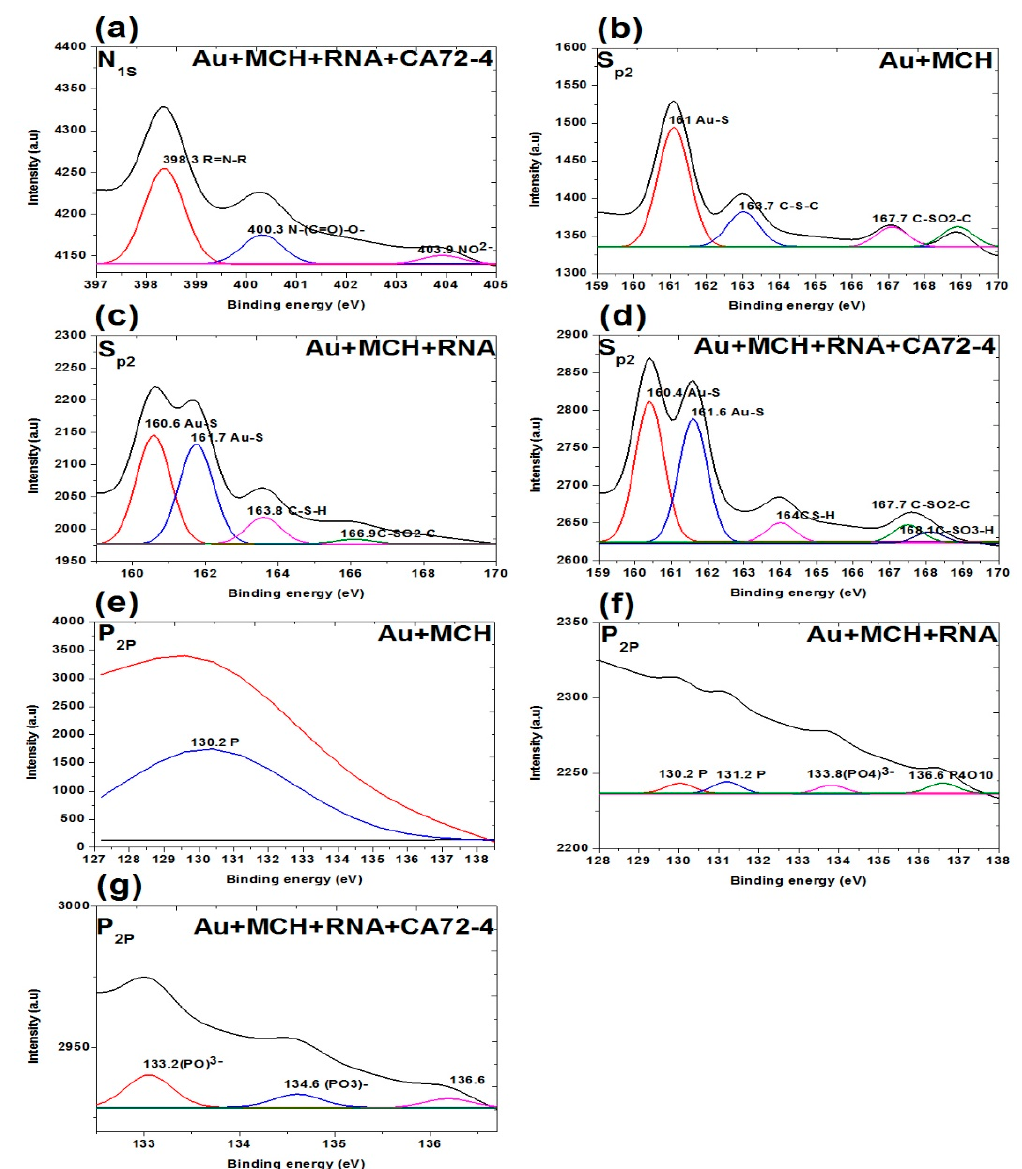
Figure 8. XPS analysis of adsorption of different concentrations of cancer antigen CA 72-4 on our electrochemical sensor. ( a ) N 1s analysis of Oligo-RNA-modified and detected CA72-4. ( b ) S p2 studies on MCH-modified gold membrane. ( c ) S p2 region of the Oligo-RNA membrane. ( d ) S p2 results of Oligo-RNA-modified and detected CA72-4. ( e ) P 2p region of MCH-modified gold membrane. ( f ) P 2p region of Oligo RNA. ( g ) P 2p region of Oligo RNA and CA72-4.